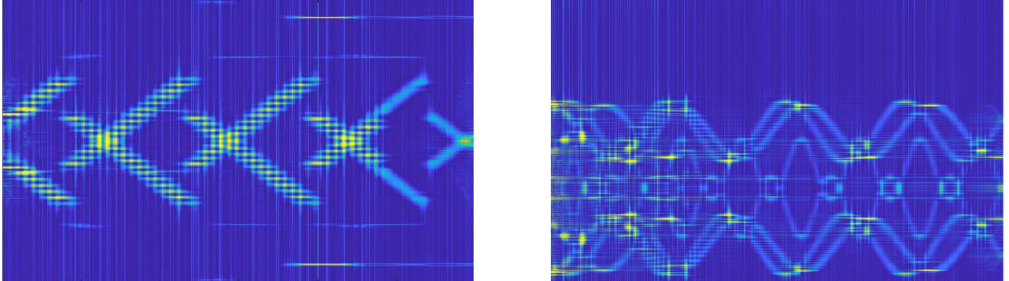
Figure 7. Time- frequency diagram of multisignal CWD after noise suppression (−15 dB).